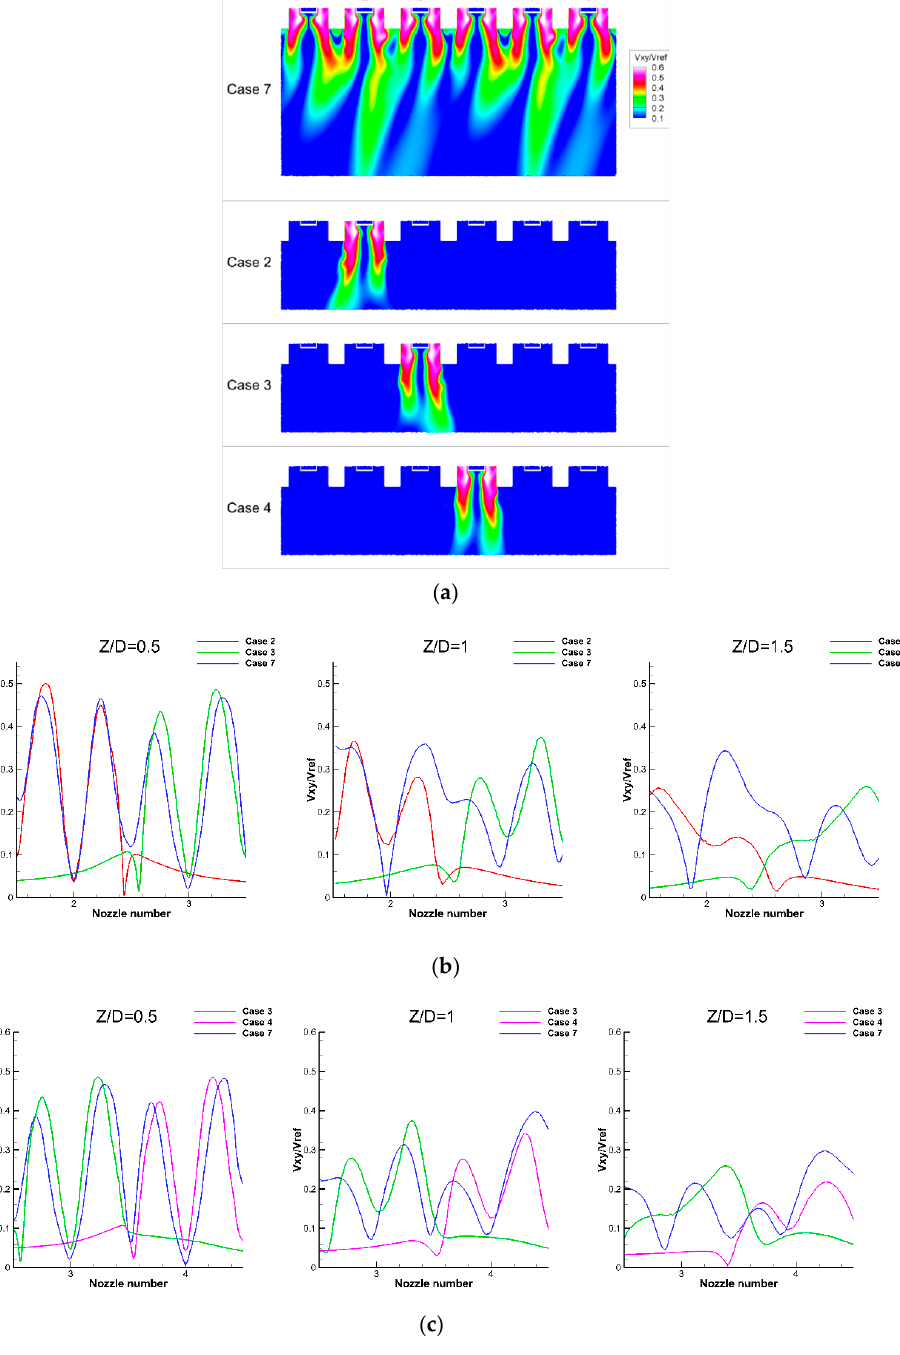
Figure 17. V xy on planes. ( a ) V xy on Iso-surface R/D = 1.6 in different cases; ( b ) V xy between nozzle 2 and 3 in Case 2, Case 3 and Case 7; ( c ) V xy between nozzle 3 and 4 in Case 3, Case 4 and Case 7. The central symmetry of the flow in the combustion chamber was further proven. In Figure 17a, the flow downstream of nozzles 1, 2 and 3 was similar to that downstream of nozzles 4, 5 and 6. In Figure 17b,c, the V xy deviated from the nozzle’s center. This suggests that the flow in the combustion chamber was constantly rotating counterclockwise be- cause the total momentum of the counterclockwise rotation was greater than that of the clockwise rotation. The generation of the recirculation zone is one of the main phenomena inside the combustion chamber, which is important for stabilizing the flame. Figure 18a,c,d shows the z -velocity on each plane, and Figure 18b shows the length and width of the recircula- tion zones downstream of nozzles 2, 3 and 4 before and after coupling. ( a )